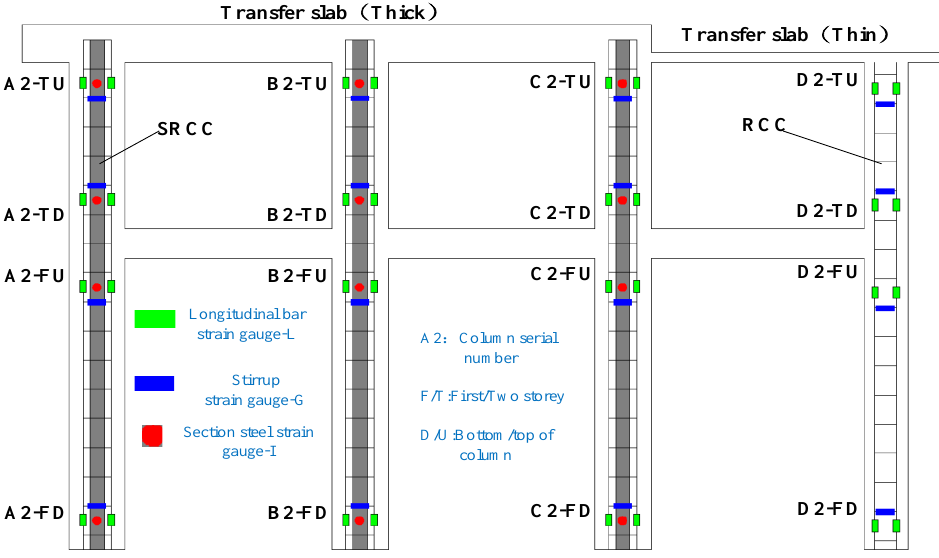
Figure 11. Frame column strain layout plan.